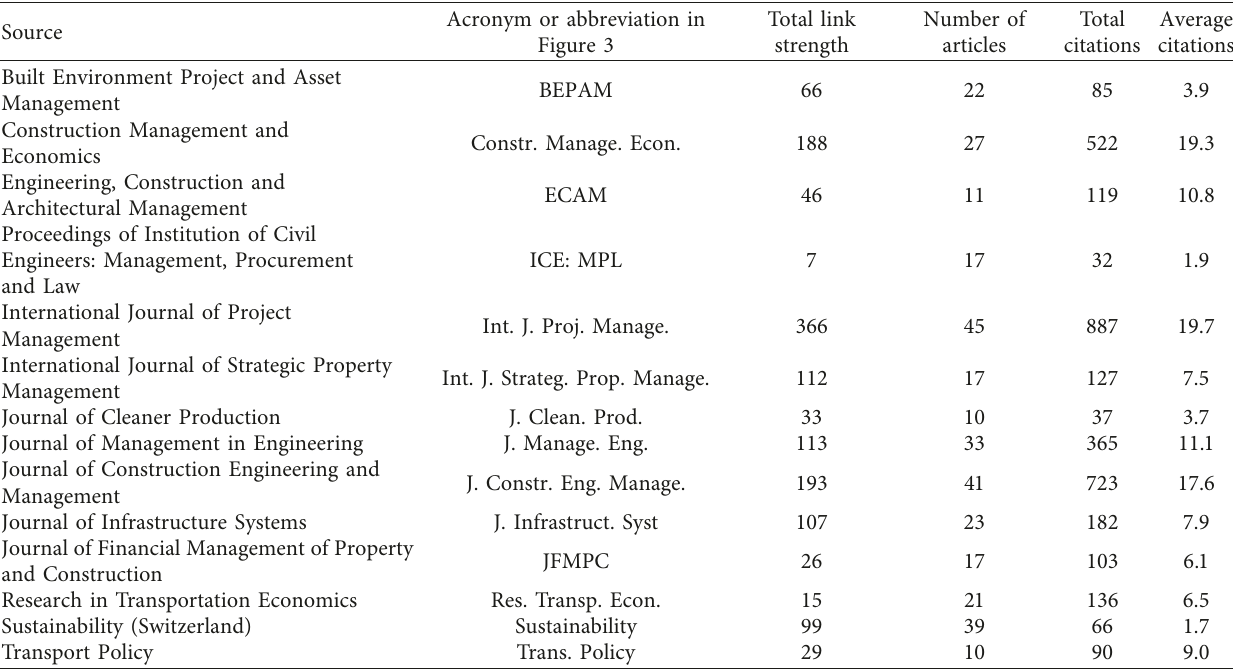
Table 1: Analysis of sources in PPP.